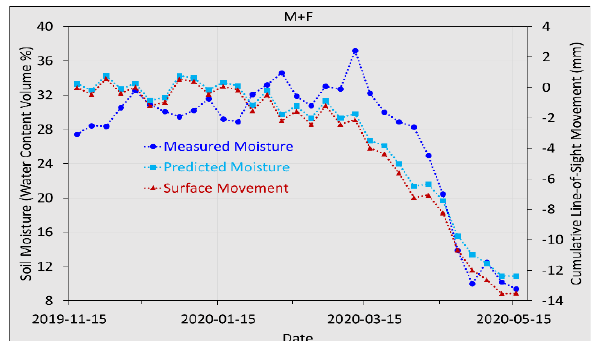
Figure 8. Comparison of soil moisture and SBAS-derived movement at M+F (Figure 3).